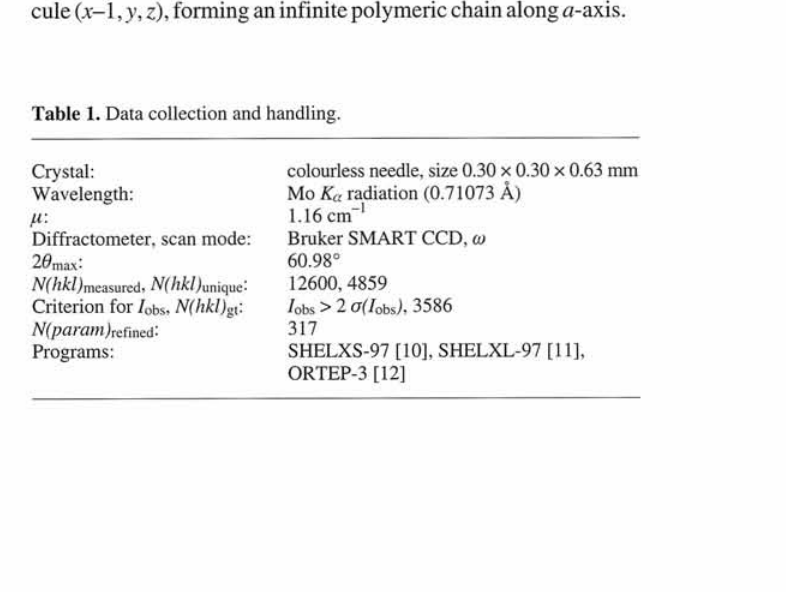
Table 1. Data collection and handling. Crystal: Wavelength: μ· Diffractometer, scan